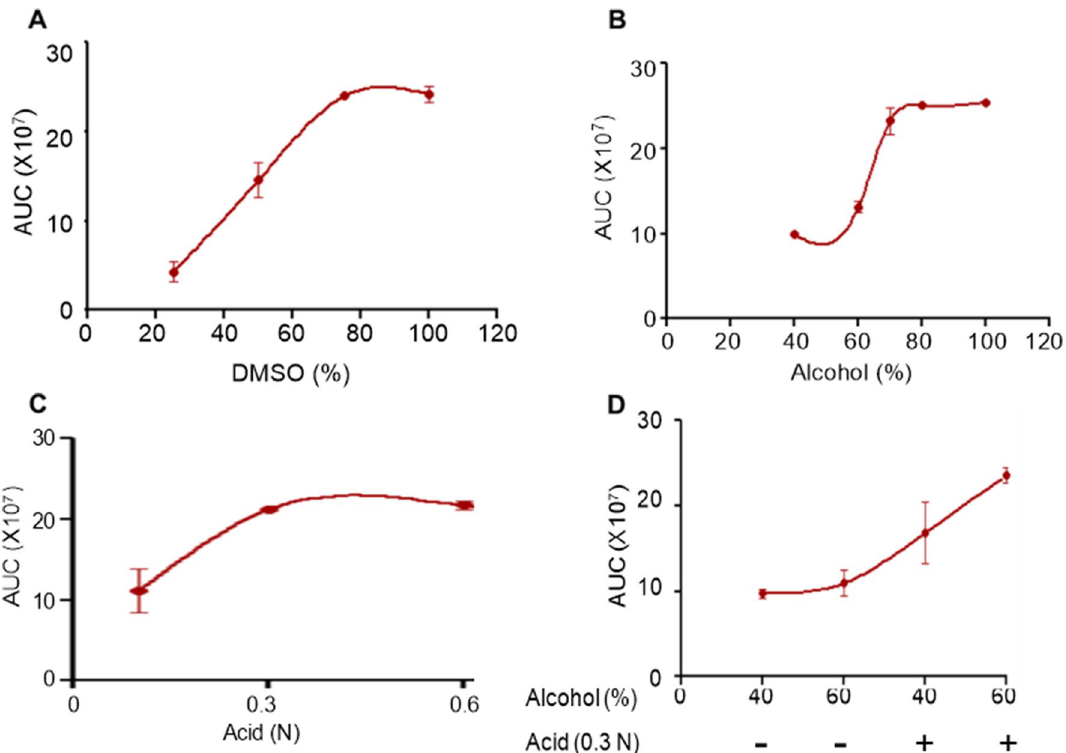
Figure 1. Evaluation of solubility of Disarib in different solvents. ( A–C ) Solubility of Disarib in different concentration of DMSO ( A ), alcohol ( B ) and HCl ( C ). Concentrations used were 25, 50, 70 and 100% for DMSO, 40, 60, 70, 80, and 100% for alcohol and 0.1, 0.3 and 0.6 N for HCl. ( D ) Analysis of solubility in alcohol (40, 60%) in combination with HCl. In each panel, HPLC analyses were performed at three independent